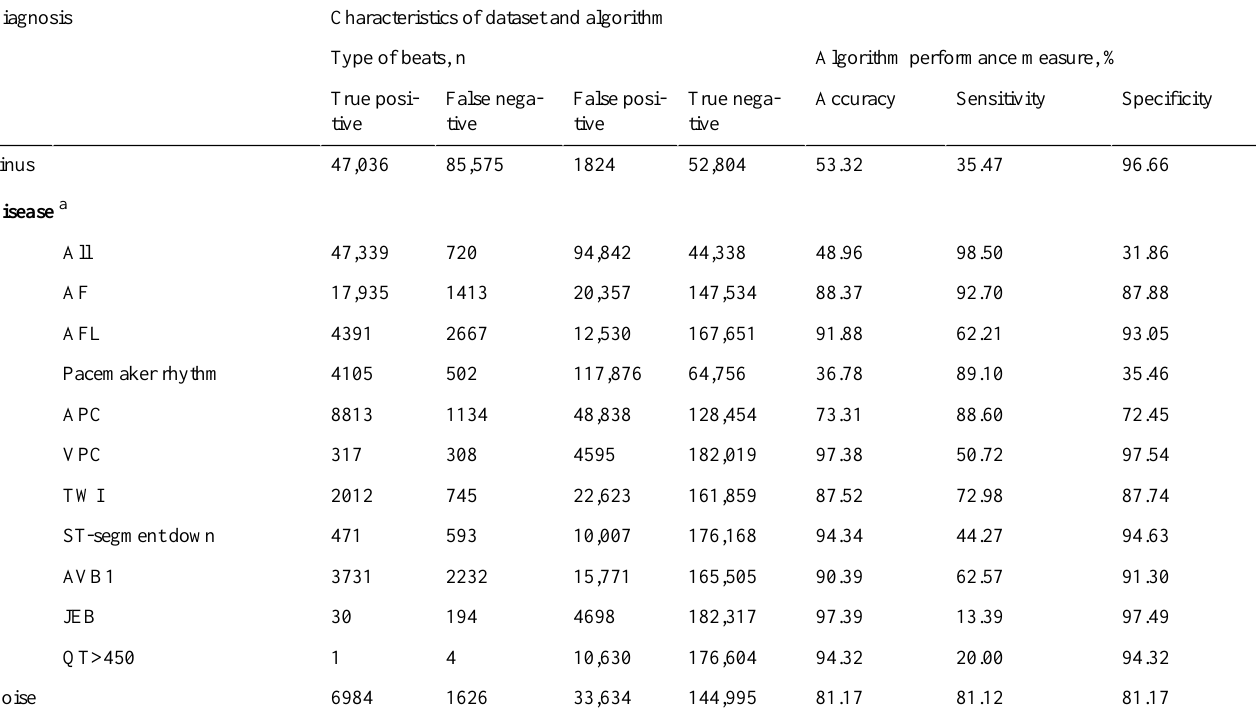
Table 4. Electrocardiogram classification performance for the dataset from the Telehealth Center of the National Taiwan University Hospital. Characteristics of dataset and algorithmDiagnosis